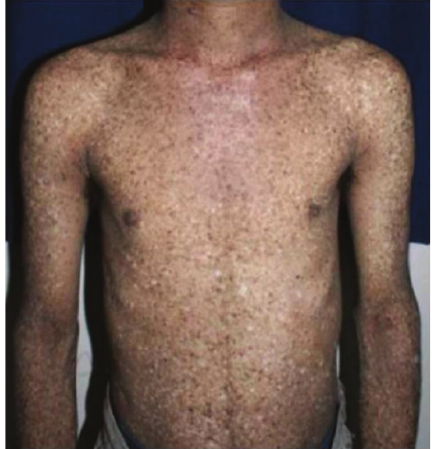
Figure2:Mottledhyperpigmentedandhypopigmentedareasgiving salt and pepper appearance to